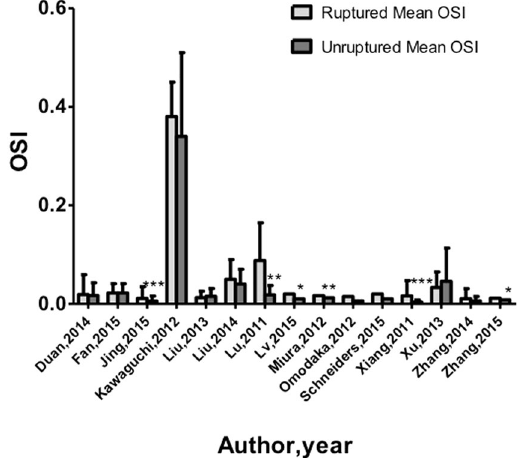
Figure 4. The magnitude of repoted oscillatory shear index.